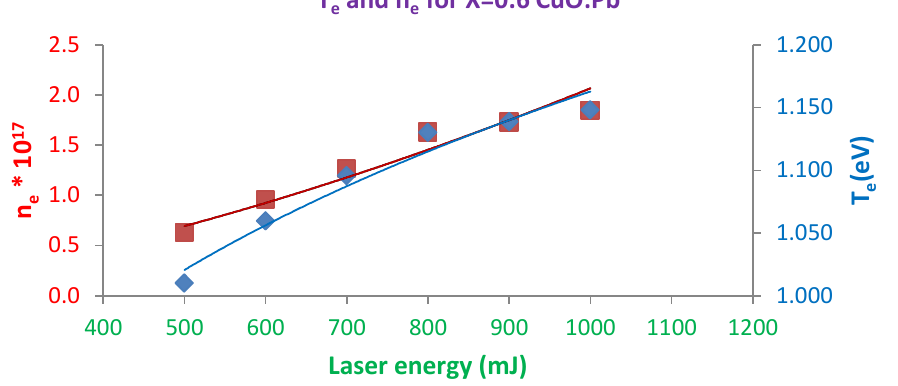
Fig. 6: The variation of (T Vacuum.